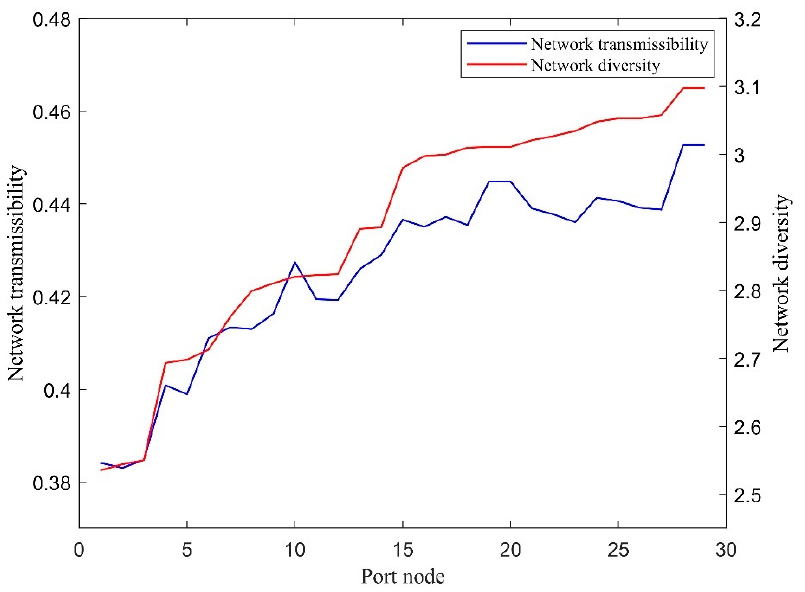
Figure 3. East Asian regional shipping network resilience when all port nodes individually fail in